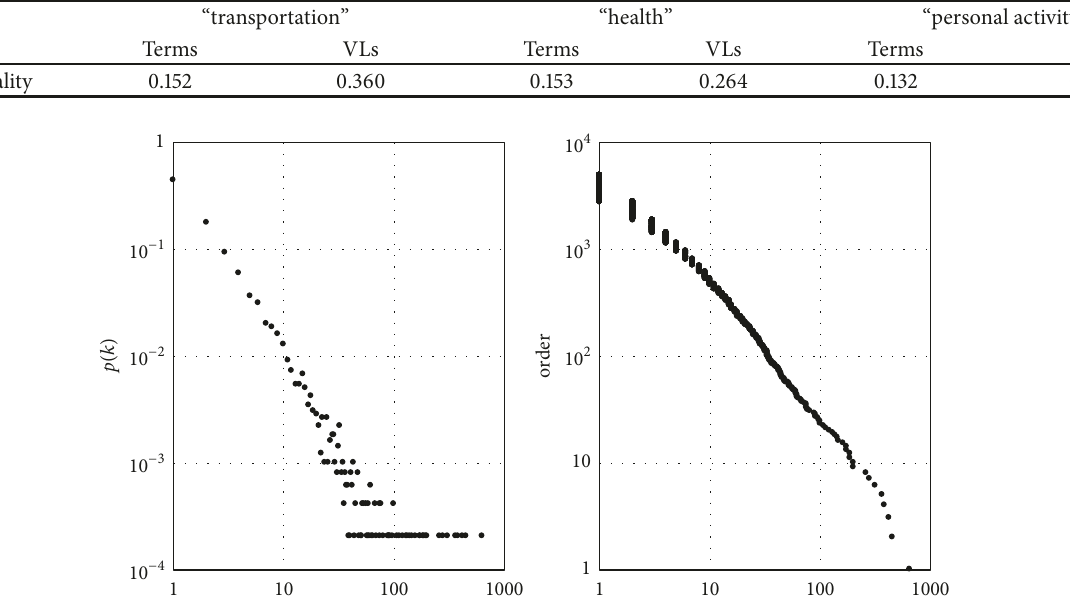
Figure 3: Distributions of the terms in Corpus.